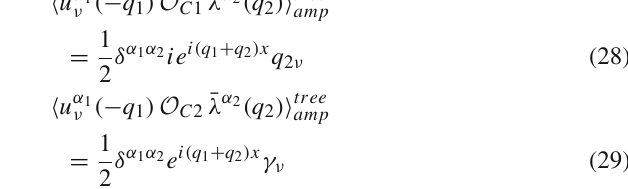
Fig. 1 One-loop Feynman diagrams contributing to the two point Green’s function of the Gluino-Glue operator, (cid:7) u ν O Gg ¯ λ (cid:5) . A wavy (dashed) line represents gluons (gluinos). A cross denotes the insertion